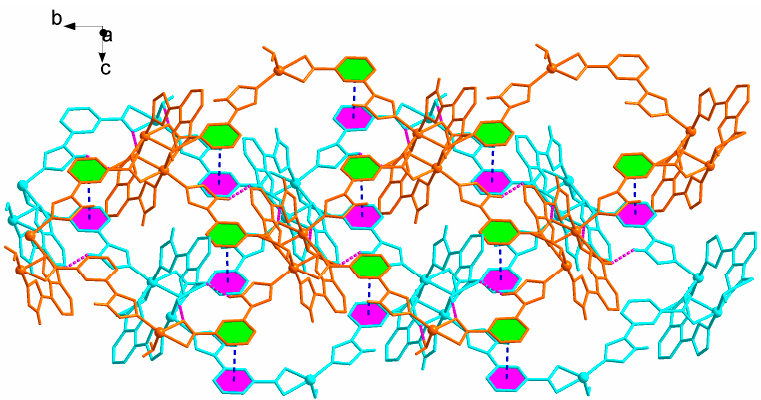
Figure 5. The 2D network structure (left) and the representation of 6 3 - hcb framework of 2 (right).